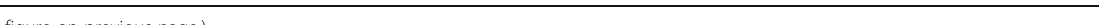
(See figure on previous page.) Fig. 1 Docking results of Levamisole (standard drug), piperine, piperlonguminine, and N-isobutyl deca- trans -2- trans -4-dienamide with TUBULIN-COLCHICINE enzyme (PDB: 1SAO) for anthelmintic activity. The colors indicate the residue (or species) type: Red-acidic (Asp, Glu), Green-hydrophobic (Ala, Val,Ile, Leu, Tyr, Phe, Trp, Met, Cys, Pro), Purple-basic (Hip, Lys, Arg), Blue-polar (Ser, Thr, Gln, Asn, His, Hie, Hid), Light gray-other (Gly, water), Darker gray-metal atoms. Interactions with the protein are marked with lines between ligand atoms and protein residues: Solid pink — H-bonds to the protein backbone, Dotted pink-H-bonds to protein side chains, Green — pi-pi stacking interactions, Orange-pi-cation interactions. Ligand atoms that are exposed to solvent are marked with gray spheres. The protein “ pocket ” is displayed with a line around the ligand, colored with the color of the nearest protein residue. The gap in the line shows the opening of the pocket